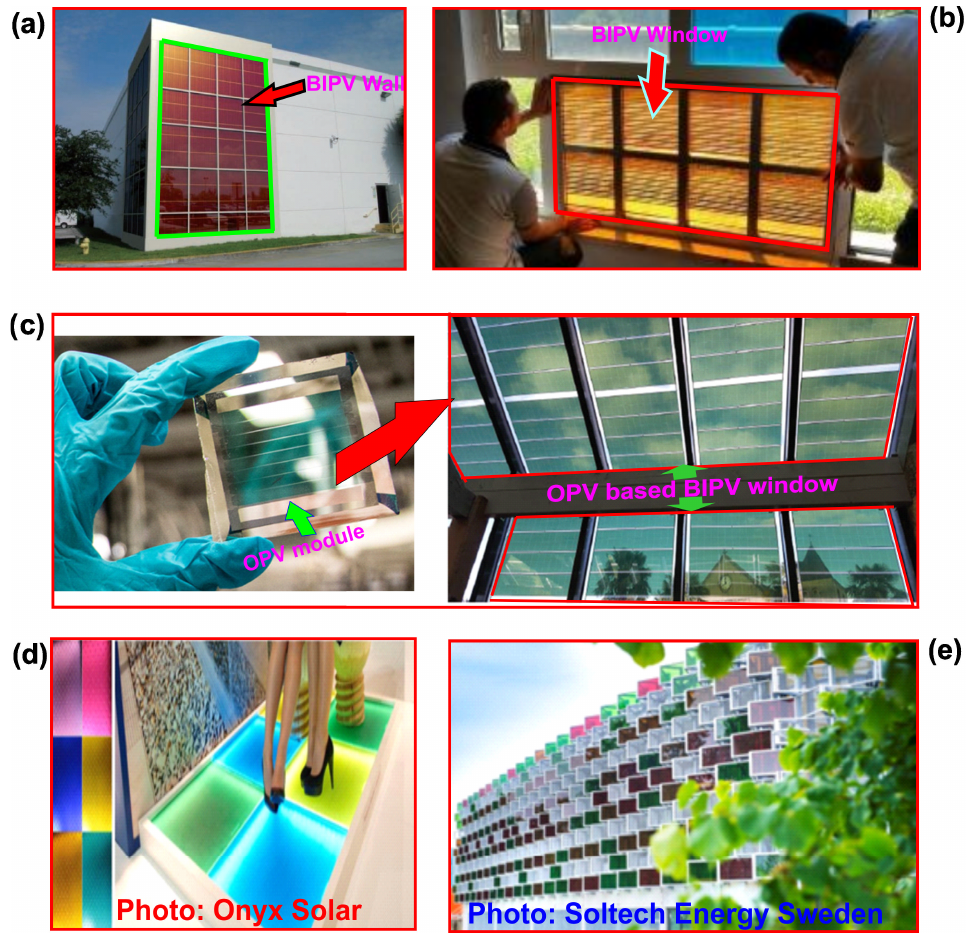
Figure 4. Semitransparent and colored BIPV modules and their applications. ( a ) DSSC-based red- orange colored wall installation [54], which is marked by the Green rectangular line; System provider. Konarka Technology (this company is out of market [59]), ( b ) DSSC-based yellow-orange colored window installation marked by the red line; system provider: Daunia solar cell (reproduced and modified from Ref. [53]), ( c ) OPV module; (image courtesy: Robert Coelius/Michigan